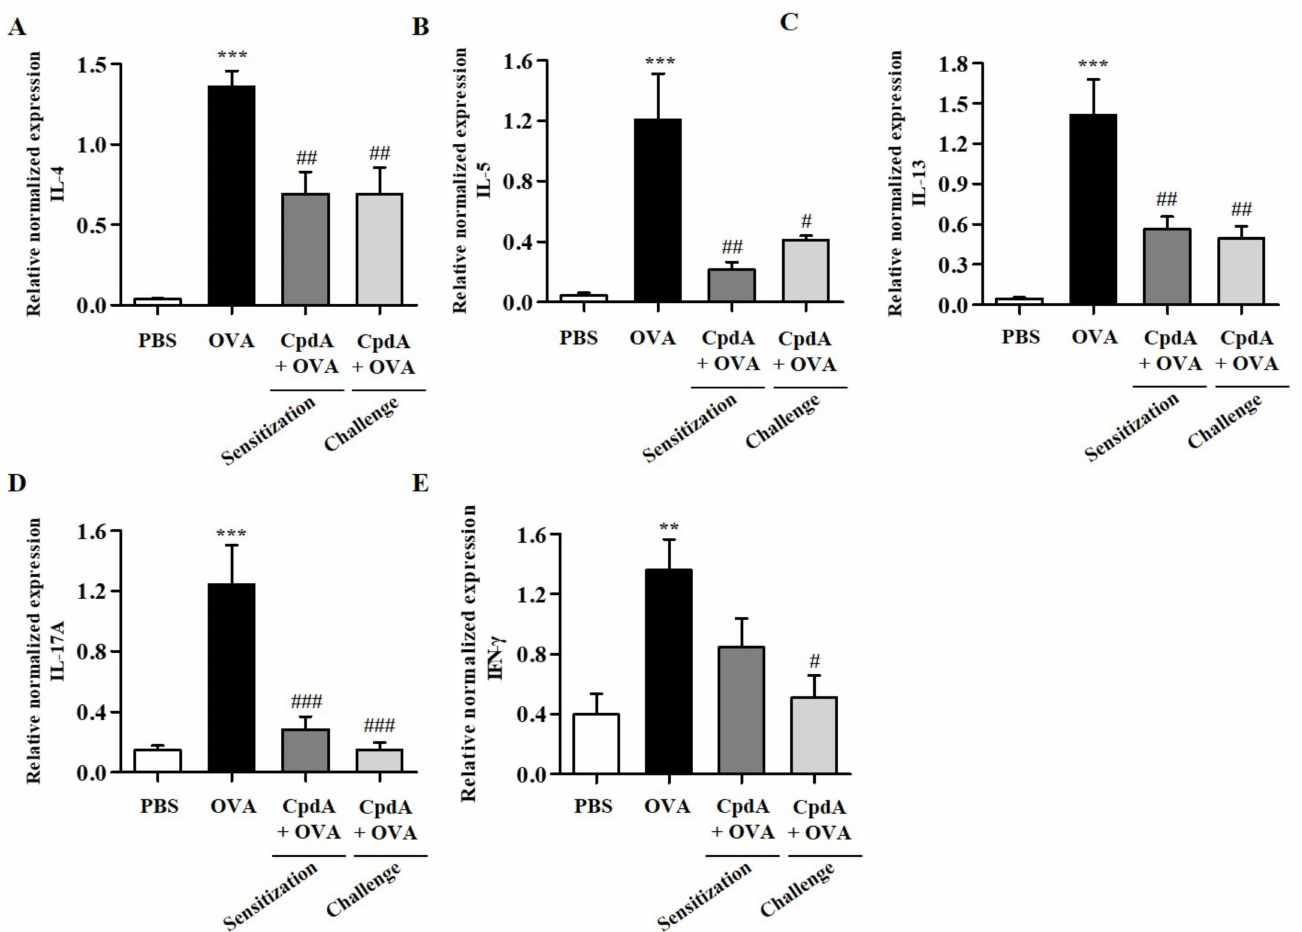
Figure 5. Effect of compound A on expression levels of T H 2, T H 17, and T H 1 cytokines in the lung tissues of OVA-induced asthma in FFA4-WT mice. Analysis of mRNA expression of T H 2 (IL-4, IL-5, and IL-13), T H 17 (IL-17A), and T H 1 (IFN- γ ) cytokines in the lung tissues of OVA-induced and compound A-treated FFA4-WT mice. Relative mRNA levels of cytokines were quantified as ratios to GAPDH transcript levels. ( A ) IL-4, ( B ) IL-5, ( C ) IL-13, ( D ) IL-17A, and ( E ) IFN- γ . The results are presented as mean ± SEM ( n = 5). ** p < 0.01, *** p < 0.001 vs. the PBS-treated group, # p < 0.05, ## p < 0.01, ### p < 0.001 vs. the OVA-treated